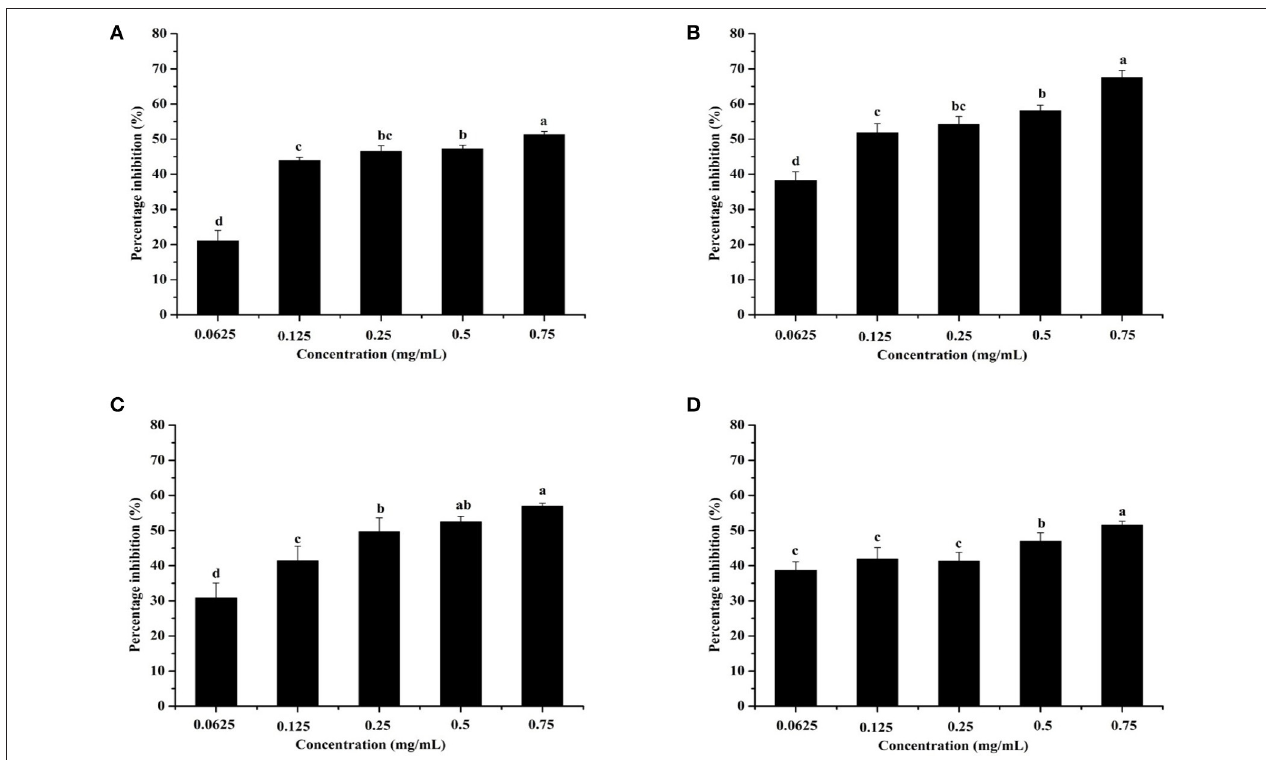
FIGURE 1 | Effects of the Camellia nitidissima Chi flower fractions on pyocyanin production. Ethanolic extract (A) , Dichloromethane fraction (B) , Ethyl acetate fraction (C) , and N-butanol fraction (D) . Means with different small letters (a–d) are significantly different ( p < 0.05).